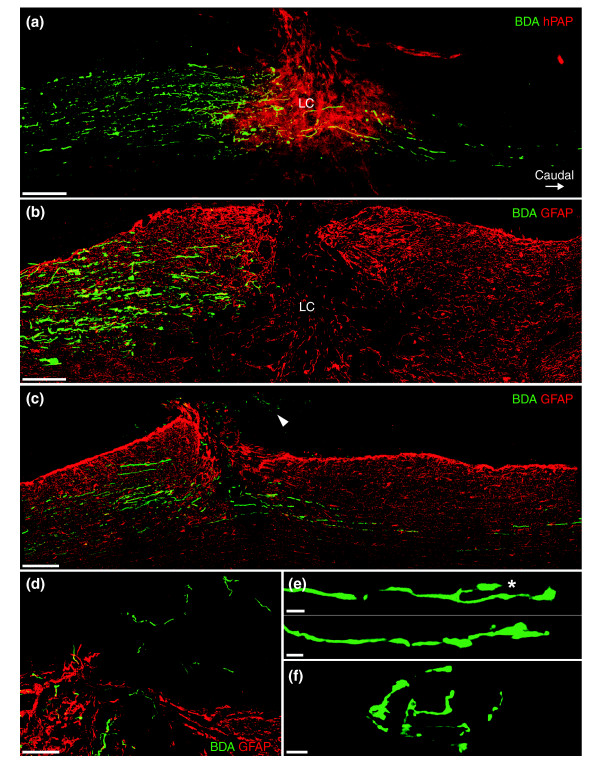
Transplanted GDAs promote regeneration of rubrospinal axons. (a) Confocal montage scanned through a depth of 60 μm, showing a small population of BDA+ rubrospinal tract (RST) axons (green) that have traversed a GDA-bridged (red) lesion of the dorsolateral funiculus and entered caudal white matter at 8 days after injury. The majority of RST axons, however, have sprouted to within 300 μm of the lesion center (LC) but failed to extend beyond the site of injury. Note the absence of BDA-labeled axons within the dorsal-most regions of the injury site. (b) Confocal montage showing the complete failure of axotomized BDA+ RST axons to cross control lesions at 8 days after injury and that the majority of axons have remained within rostral lesion margins at a distance of 500–800 μm from the lesion center (LC). (c) At 5 weeks after injury and transplantation, a small population of BDA+ RST axons have traversed GDA-bridged injury sites and extended within caudal white matter. Note that BDA+ axons have also sprouted into the dorsal regions of the lesion center and even extended beyond the pial surface (arrowhead; see also the high-power image in (d)). Note the lower levels of GFAP immunoreactivity (red) in more ventral regions of the injury margins and center, coincident with the presence of BDA+ axons. (e) Two examples of RST axons displaying growth cones within white matter 2 mm caudal to a GDA-treated lesion, at 5 weeks after transplantation. Note the collateral branch (asterisk). (f) Confocal image of a BDA+ terminal field-like axonal plexus within layer 5 spinal cord gray matter, immediately adjacent to the dorsolateral funiculus white matter at 5 weeks after injury and transplantation. In contrast, in all GDA-transplanted rats and controls injected with medium alone at 8 days after injury, no BDA labeling was observed within gray matter beyond the injury site. Scale bars: (a-c) 200 μm; (d) 100 μm; (e) 5 μm; (f) 10 μm.